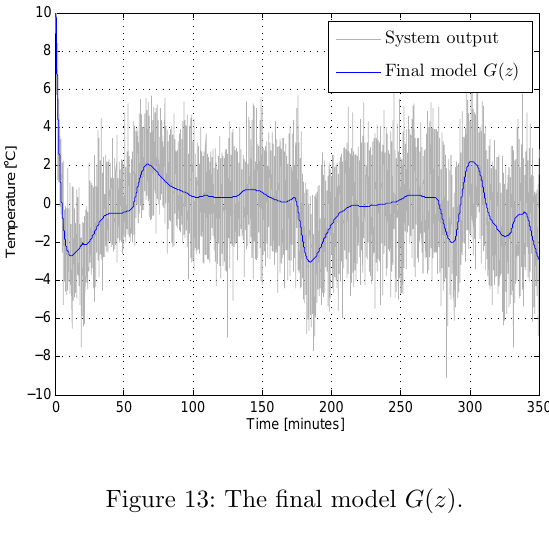
0 , 1 , 2 and n f 1 , 2 , 3 . ∈ { } ∈ { }